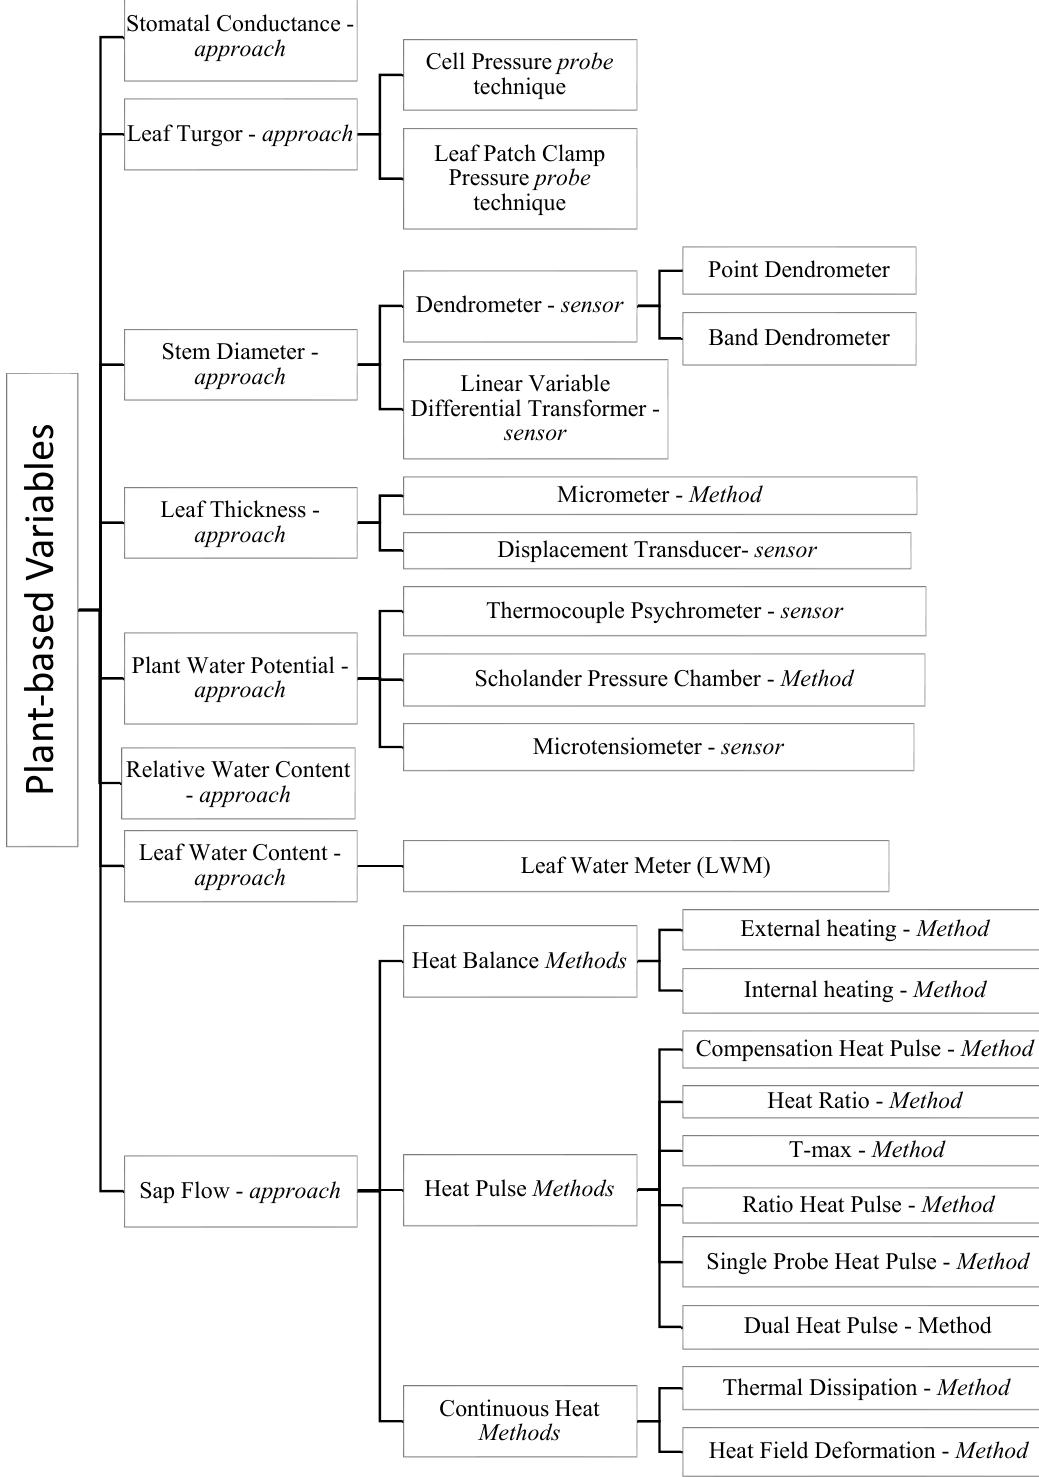
Figure 1. Graphical scheme describing the different plant-based variables and approaches, and the respective technology or sensors used to estimate plant water status. The approaches measure physiological variables by means of different methods and instruments.